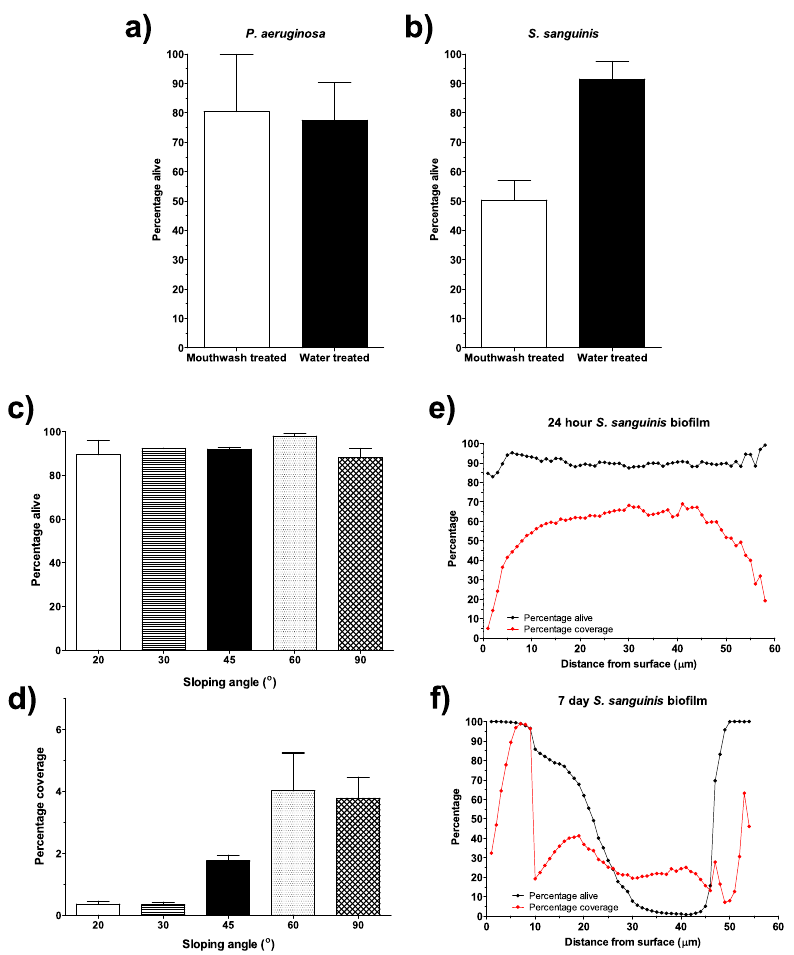
Fig. 3 Translation of image analysis method to research applications. a , b Simple mouthwash study comparing bio fi lms of a P. aeruginosa and B S. sanguinis treated with mouthwash or water ( n = 3 for all conditions). c , d Analysis of S. epidermidis bio fi lms grown on additively manufactured coupons at different sloping angles: c Percentage alive and d Percentage coverage. e , f Bio fi lm coverage and viability with increasing distance from coverslip for e a 24-h bio fi lm of S. sanguinis and f 7-day bio fi lm of S. sanguinis . Z-stacks were taken at 1 µm increments from the surface (the fi rst plane in which bacteria were identi fi ed), and hence the distance from the surface is equivalent to the bio fi lm